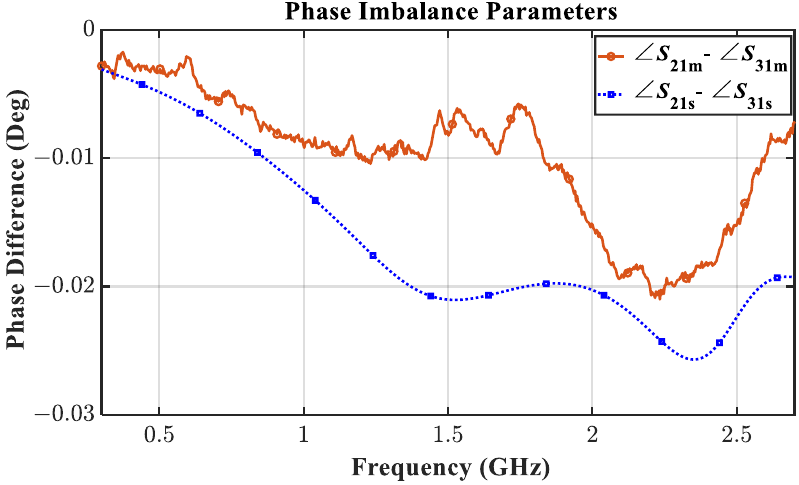
Figure 13. Simulated (subscript s) vs measured (subscript m) phase imbalance between output ports.